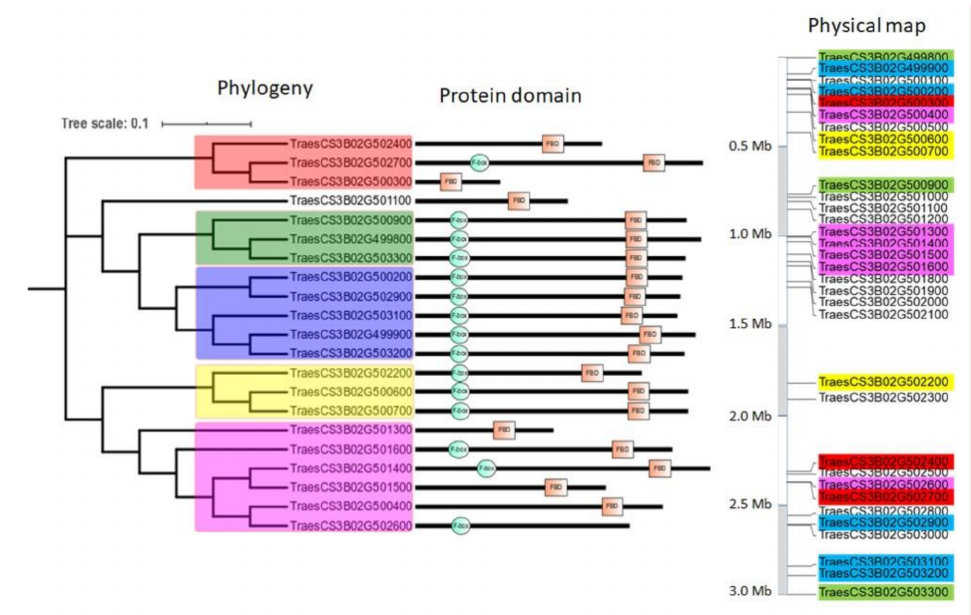
Figure 8. Phylogenetic tree of the 21 genes containing a FBD domain (red box) and/or a F-box domain (green circle), and their physical distribution on a 3 Mb part of the chromosome 3B-R3 region. The different clades are delimited by various colors, reported onto the physical map to identify their spatial